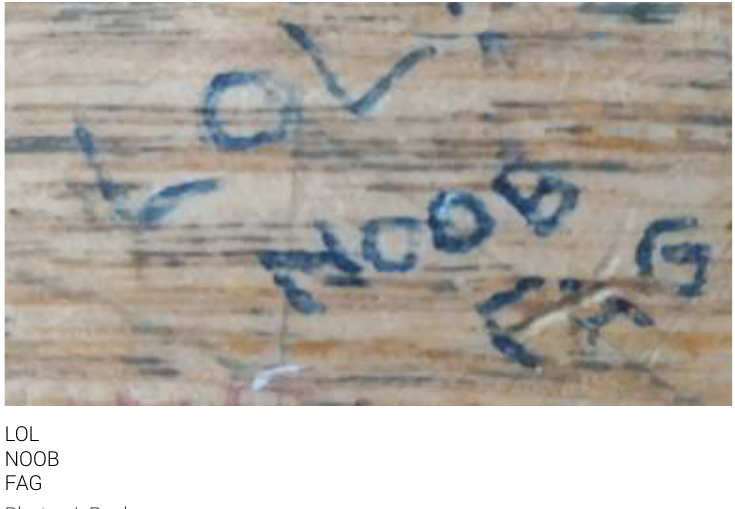
LOL NOOB FAG Photo: J.